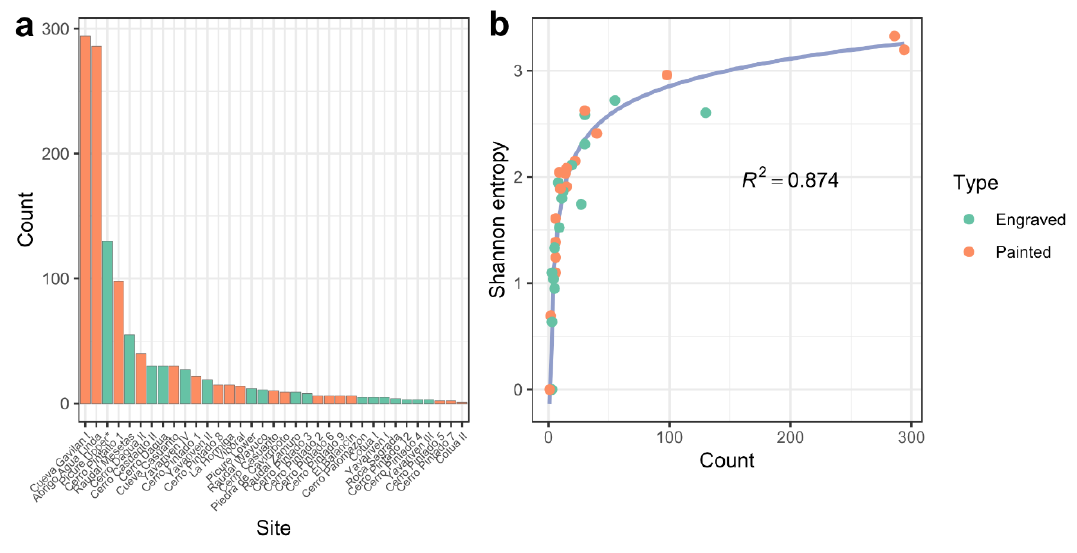
Figure 3. Descriptive attributes of the Middle Orinoco rock art assemblage. ( a ) Counts of rock art motifs per site by type of art. The distribution of counts is log-normal. ( b ) Diversity of each rock art site against site motif count, fitted to an exponential function. Diversity is clearly non-linear with respect to the size of rock art sites. The adjusted fit of an exponential model improves for paintings (R 2 = 0.9021) but not for engravings (R 2 = 0.776) when the site types are considered separately.